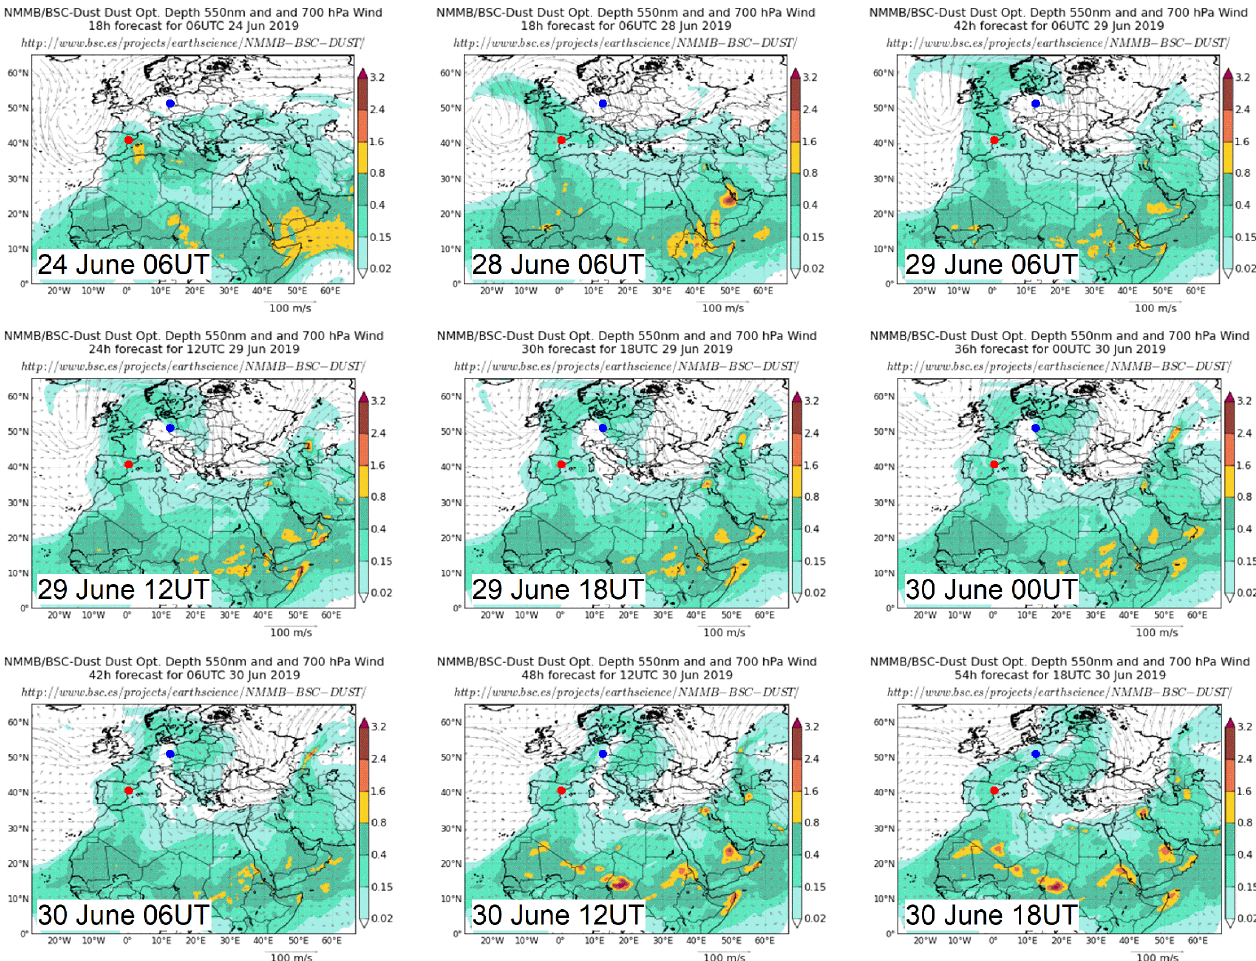
Figure 1. NMMB/BSC-Dust forecast images showing both the dust optical depth at 550nm and 700hPa wind field, illustrating the inter- continental Saharan dust outbreak observed from 23 to 30 June 2019. Both stations, BCN (41.4 ◦ N, 2.1 ◦ E) and LPZ (51.4 ◦ N, 12.4 ◦ E), are marked, respectively, by a red and a blue point. Dates and times (UT stands for UTC) are indicated in each image.